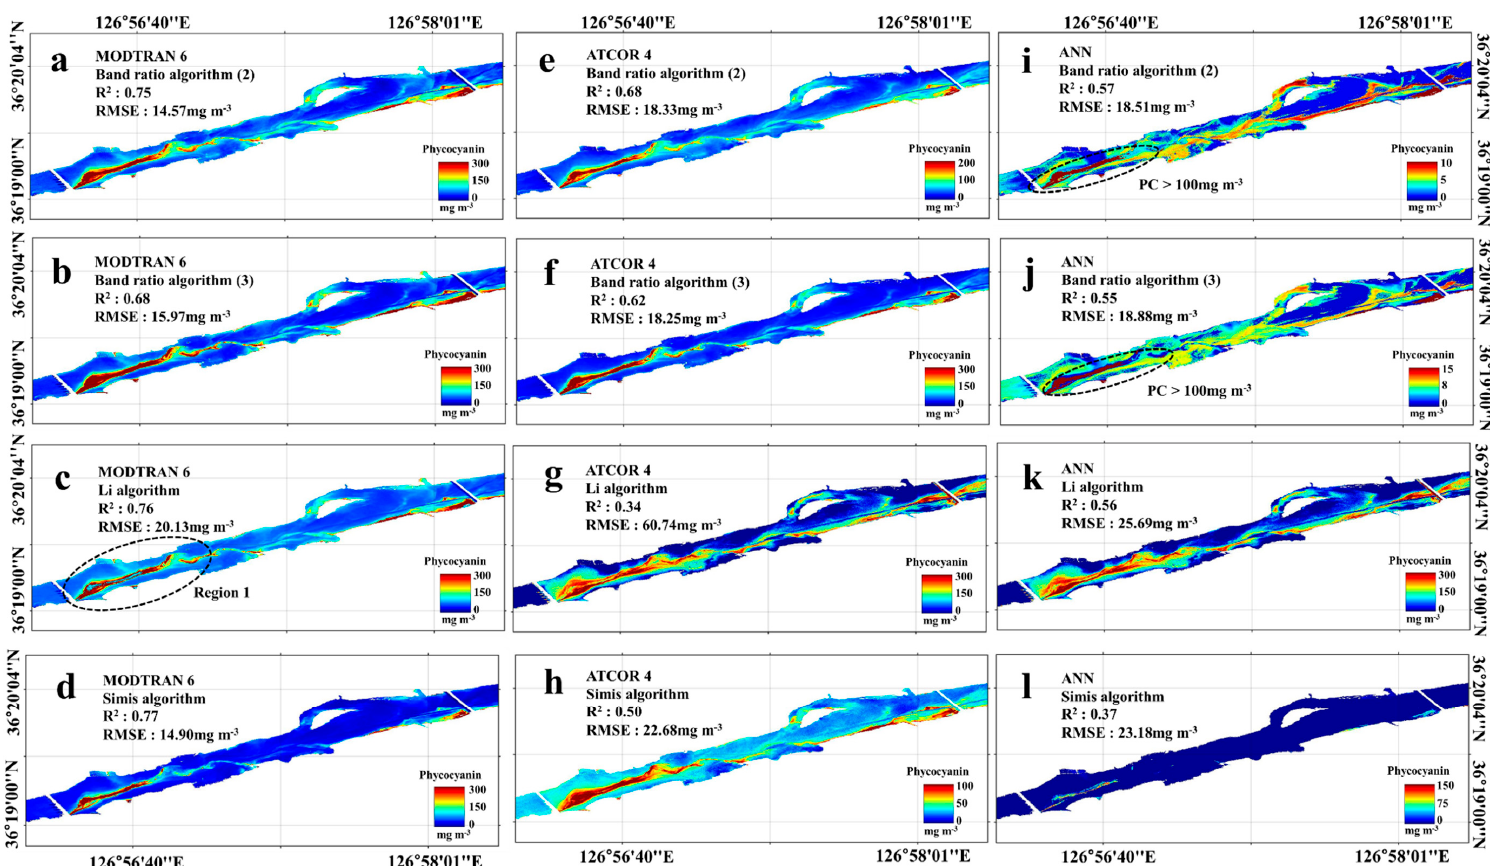
Figure 7. Phycocyanin (PC) concentration images on 12 August 2016 in Section 1. Panels ( a – d ) show the PC distribution driven by the MODTRAN 6 atmospheric correction. Panels ( e – h ) show the PC distribution driven by the ATCOR 4 atmospheric correction. Panels ( i – l ) show the PC distribution driven by the ANN atmospheric correction.